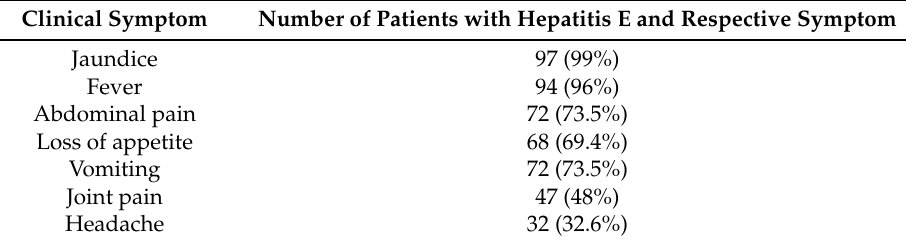
Table 2. Clinical symptoms among 98 patients with sporadic hepatitis E virus infection.